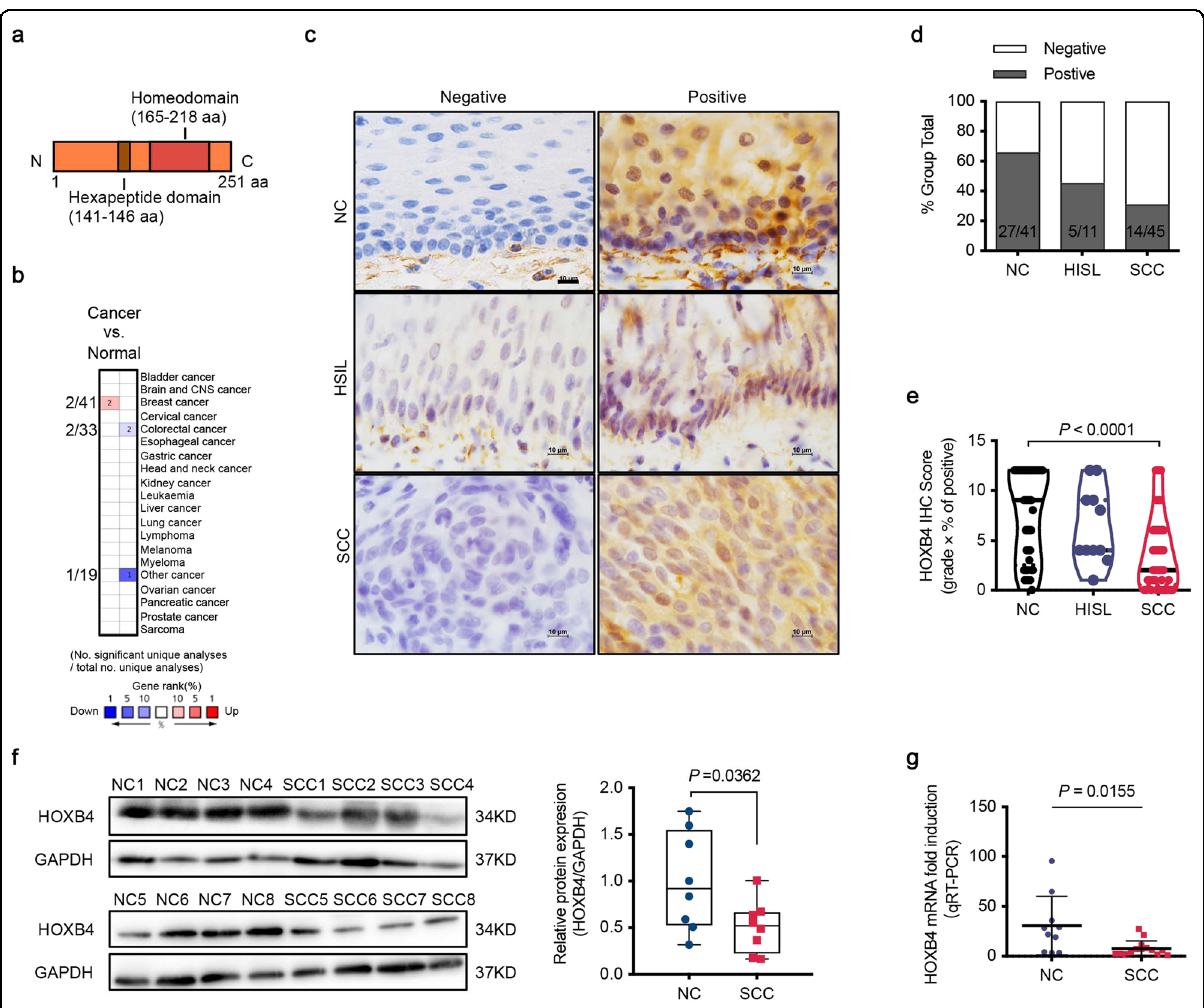
Fig. 1 HOXB4 was downregulated in cervical cancer. a Illustration of the HOXB4 domains. The relative position of the hexapeptide domain mediating cofactor (PBX) binding and the homeodomain mediating DNA binding were shown. b Oncomine analysis of HOXB4 expression in human cancers compared with normal tissues (www.oncomine.org). c – e Expression of HOXB4 in normal cervix and cervical cancer. Histopathology analysis (IHC staining) of HOXB4 was performed in 41 normal cervix (NC), 11 high-grade squamous intraepithelial lesion (HSIL), and 45 squamous cervical cancer (SCC). Representative images ( c ) with various levels of staining were shown. Scale bar: 10 μ m. HOXB4 IHC staining was classi fi ed into two categories (negative or positive). Numbers of positive cases were shown ( d ). The relative IHC score ( e ) of HOXB4 was quanti fi ed as the product of the grade of staining intensity and the percentage of positively stained cells. One-way ANOVA was used to analyze the data. f Expression of HOXB4 in human tissues. Proteins were extracted from eight normal cervix tissues and eight SCC tumors and assessed by WB, with GAPDH normalization ( f , left). The relative protein expression ( f , right) of HOXB4 was normalized to that of GAPDH using ImageJ software. g HOXB4 mRNA expression levels in ten normal cervix tissues and fourteen SCC tumors and assessed by qRT-PCR. Data were normalized to